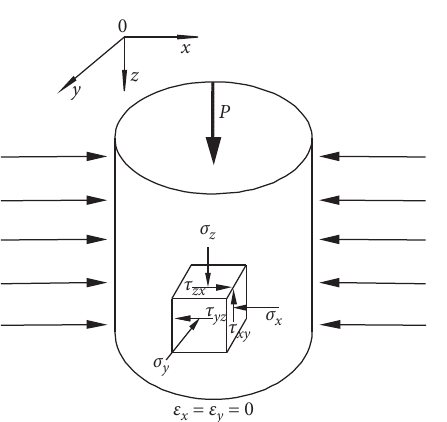
Figure 1: Stress condition of the confined compress